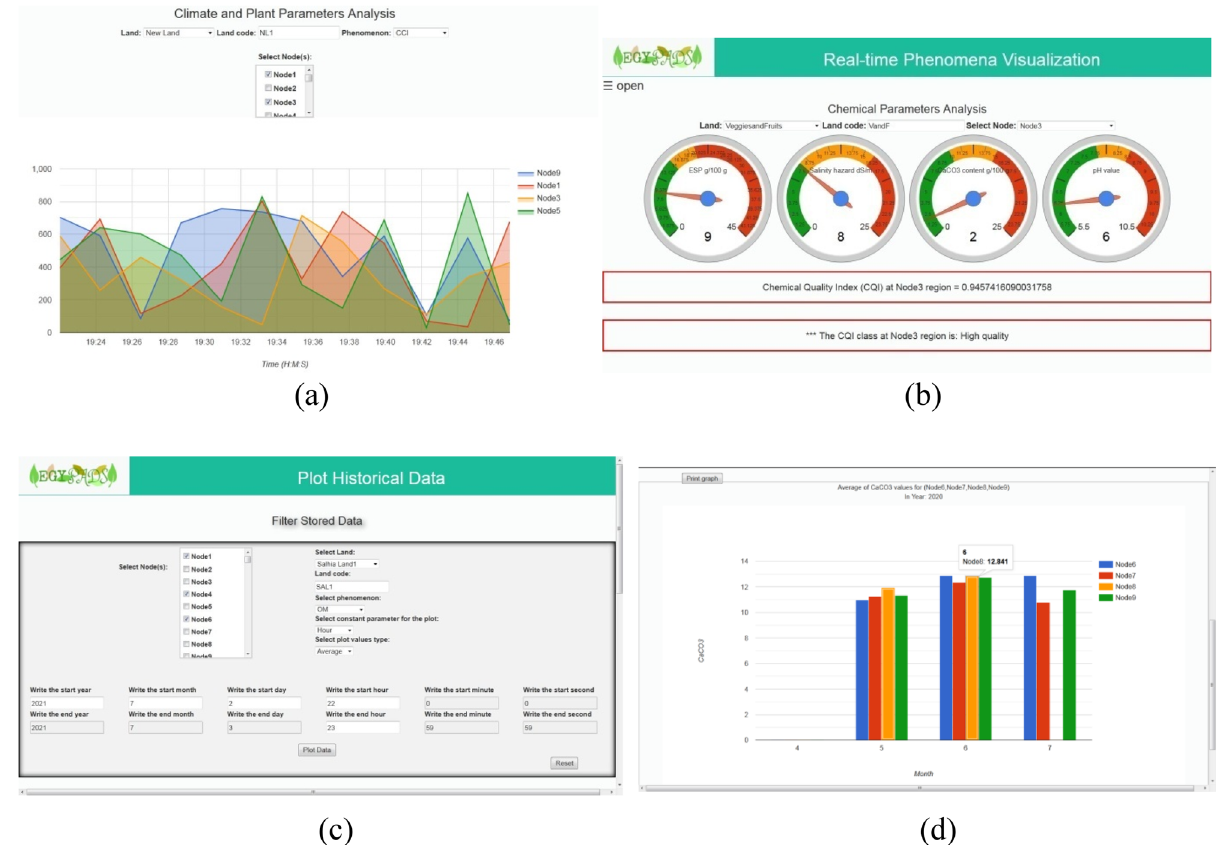
Figure 15. Screenshots of system services, ( a ) the climate and plant parameters real-time visualization service ( b ) the soil chemical parameters real-time visualization services, ( c ) the historical data visualization service " Filter Stored Data " part, ( d ) the historical data visualization service " Plot Area " part.